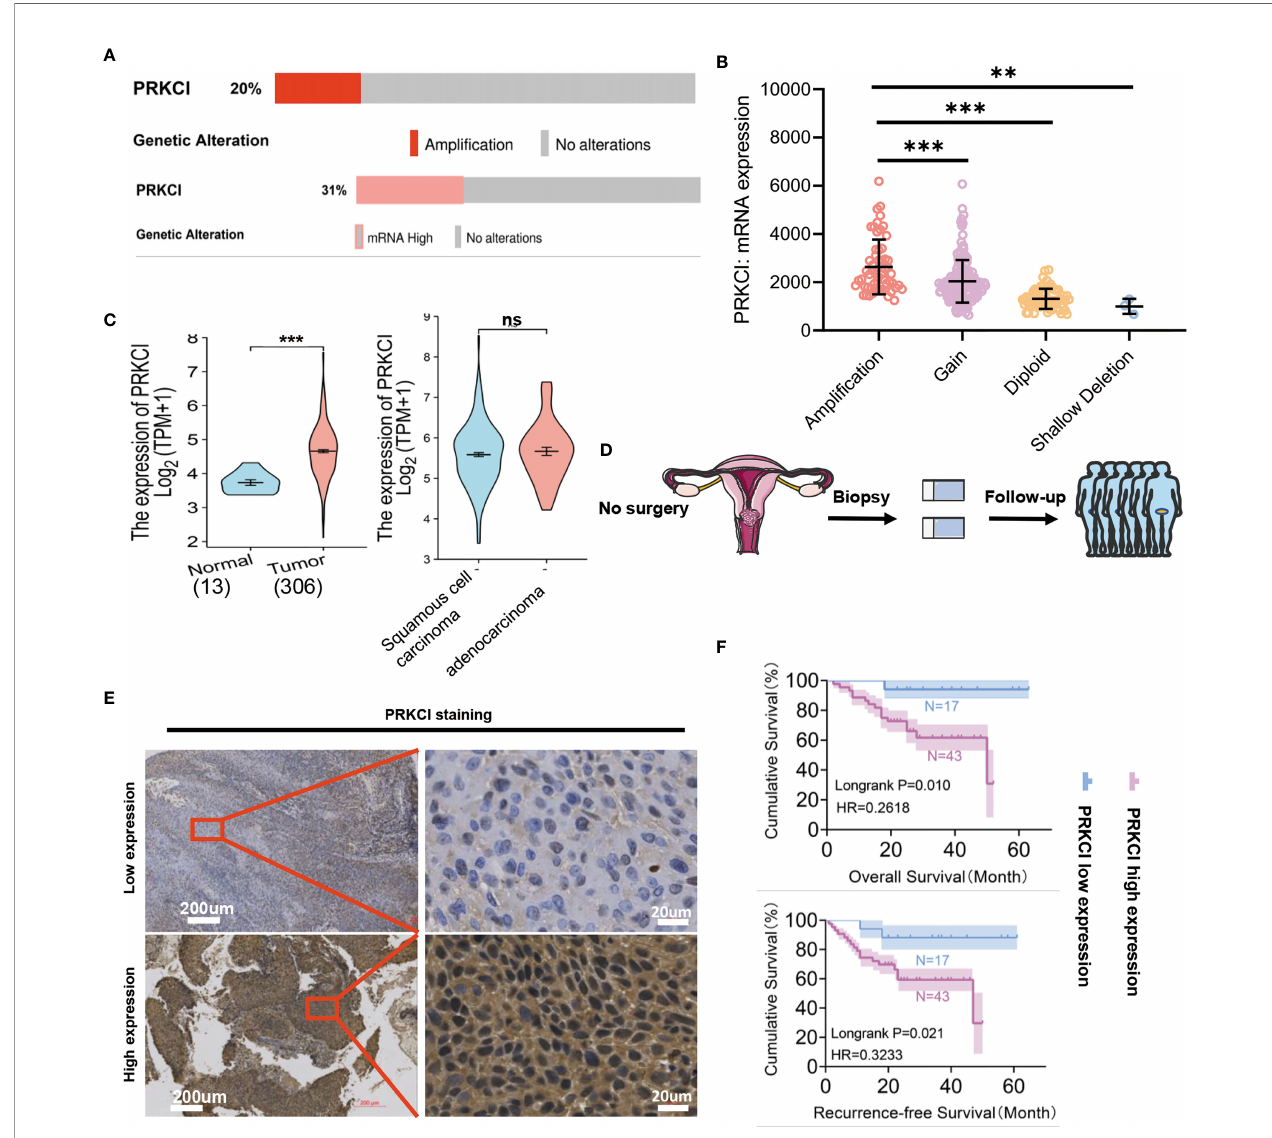
FIGURE 1 | Identi fi cation of PRKCI alterations in CC. (A) PRKCI ampli fi cation (top) and mRNA overexpression (bottom) in CC (TCGA dataset). Red bars, tumors with ampli fi cation (top); pink bar, tumors with overexpression (bottom); gray bars, tumors with no alterations in CNA (top) or expression (bottom). (B) Differences in PRKCI mRNA expression between the ampli fi ed and non-ampli fi ed groups in TCGA CESC samples. (C) Signi fi cantly elevated PRKCI expression was observed in CC tissues compared with normal specimens (TCGA dataset) (n = 319). No differences in PRKCI expression between the two pathotypes were observed. (D) Work fl ow for PRKCI identi fi cation in patients who underwent radical radiotherapy. (E) Representative images (×50 and ×400) of IHC staining for PRKCI in 60 CC patients who underwent radical radiotherapy (high expression vs. low expression). (F) Radical radiotherapy-treated CC patients with high PRKCI expression had shorter recurrence-free survival (RFS) and overall survival (OS) than patients with low PRKCI expression (n = 60). Scale bars are shown. Data are shown as the mean ± SD ( B , C ). ***p < 0.001, **p < 0.01; ns, not signi fi cant. p-Values were calculated by the log-rank test (F) . CC, cervical cancer; TCGA, The Cancer Genome Atlas; CNA, copy number ampli fi cation; CESC, endocervical adenocarcinoma; IHC,